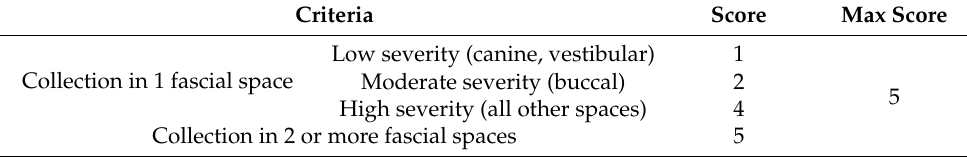
Table 1. Cont . Criteria Score Collection in 1 fascial space Collection in 2 or more fascial